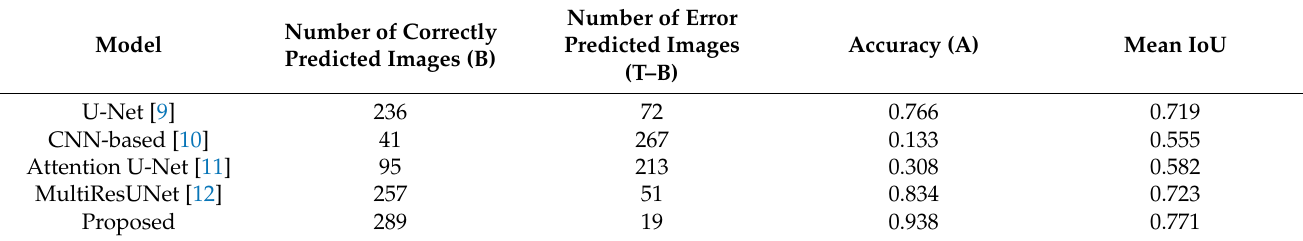
Table 1. Performance comparison of the proposed method and other methods.